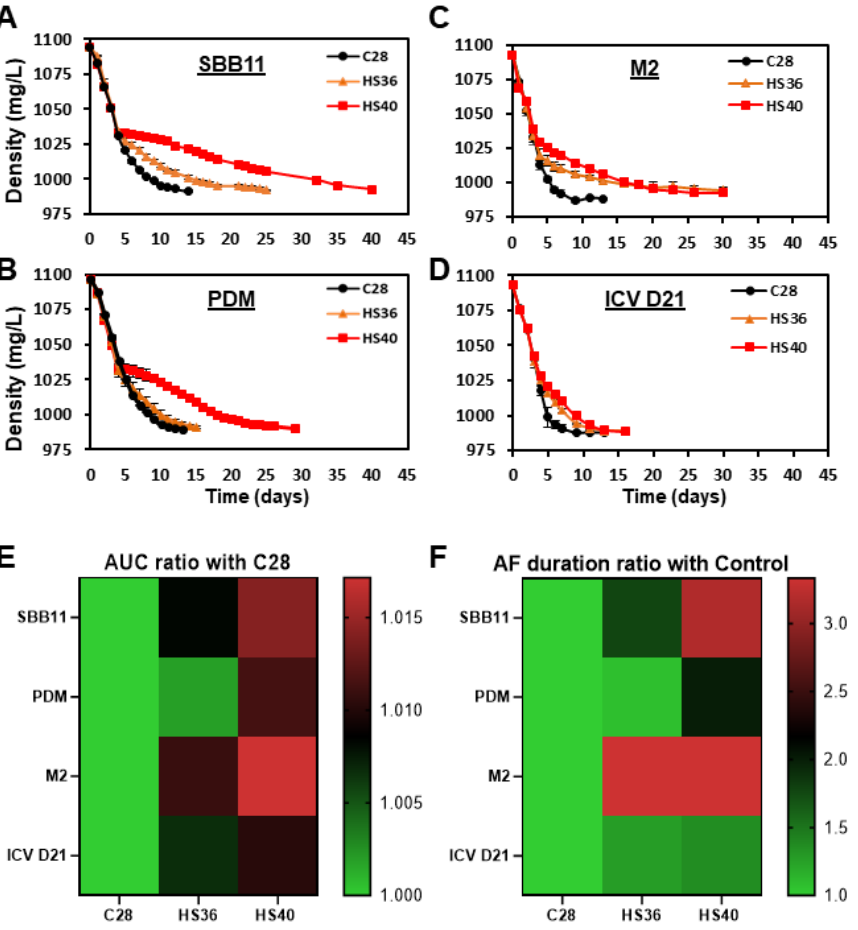
Figure 3. Evaluation of the effect of heat shock at 36 and 40 °C on AF performance for the S. cerevisiae strains SBB11 ( A ), PDM ( B ), M2 ( C ) and ICV D21 ( D ). Heat maps represent normalized data (relative to control values, C28) of AUC ( E ) and AF duration values ( F ). Table 2. Summary of parameters employed to statistically compare the impact of heat shock treat- ments on the AUC (arbitrary units) and AF duration (days) in the different strains assessed. Yeast/Treatment